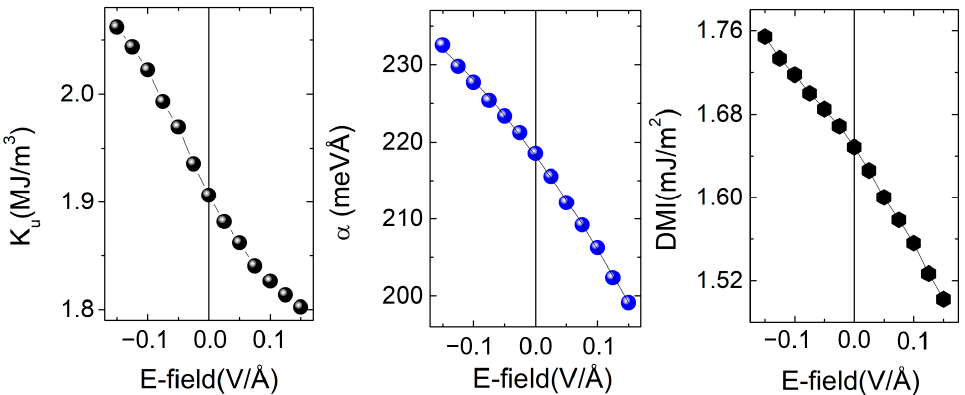
Figure 8. Electric field dependence of the surface anisotropy K u (PMA), 𝛼 (cid:3019) and DMI, here for the Au/Fe(5ML)/MgO system–(adapted from [28]). The zero field values: K u (E-field = 0) = 1.91 MJ/m 3 and DMI (E-field = 0) = 1.67 mJ/m 2 will be further used in micromagnetic simulations (see Section